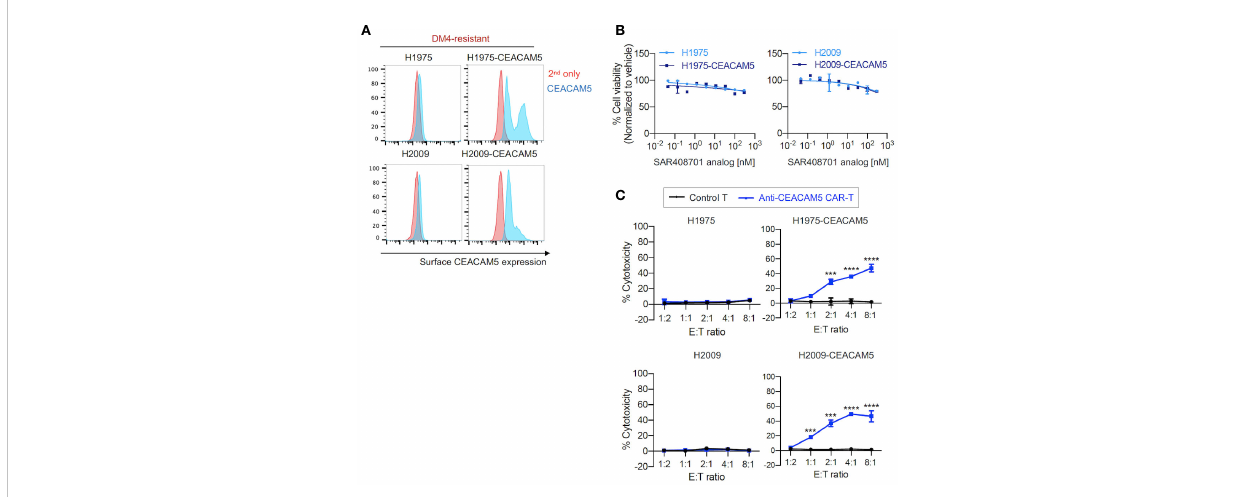
FIGURE 3 in vitro cell cytotoxicity assay of the ADC SAR408701 analog and CAR-T cells targeting CEACAM5 in DM4 R cells. (A) Cell surface CEACAM5 expression levels in DM4 R NSCLCs (H1975, H1975-CEACAM5, H2009, and H2009-CEACAM5 cells). (B) Cell killing activities with ADC SAR408701 analog against CEACAM5-positive DM4 R cell lines (H1975-CEACAM5 and H2009-CEACAM5 cells) and CEACAM5-negative DM4 R cell lines (H1975 and H2009 cells). Normalized % cell viability (ATP level) was calculated by normalizing luminescence values for vehicle (buffer)-treated respective cells. (C) Cytotoxic activities (%) of anti-CEACAM5 CAR-T cells against CEACAM5-positive and CEACAM5-negative DM4 R NSCLC cells. Signi fi cance was tested using one-way ANOVA, followed by the tukey ’ s multiple post hoc test. ****, P <0.0001; ***, P <0.001; versus control T at each E:T ratio. (B, C) Results are shown as the mean ±SD for representative data from three independent experiments.